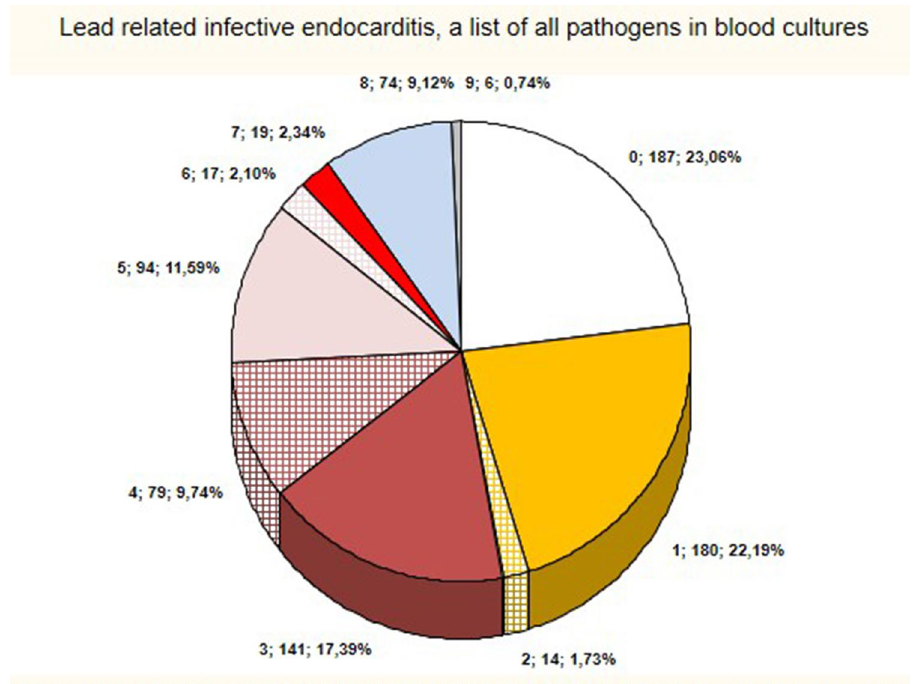
Figure 1. LRIE subgroup—list of